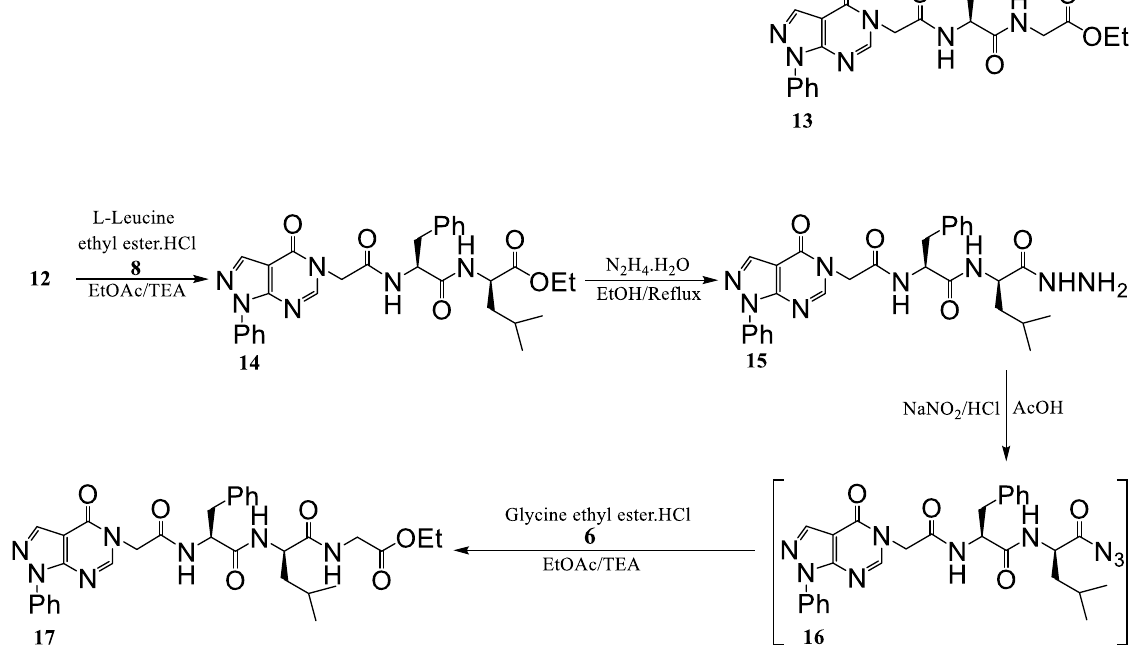
Fig. 3 Synthesis of new peptides incorporated with pyrazolopyrimidine